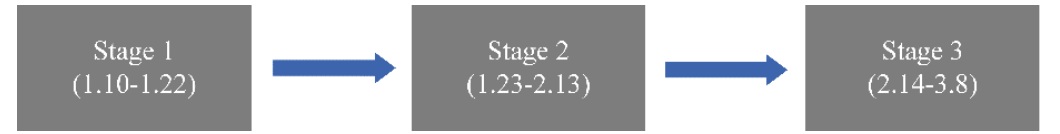
Figure 2. Outbreak stages